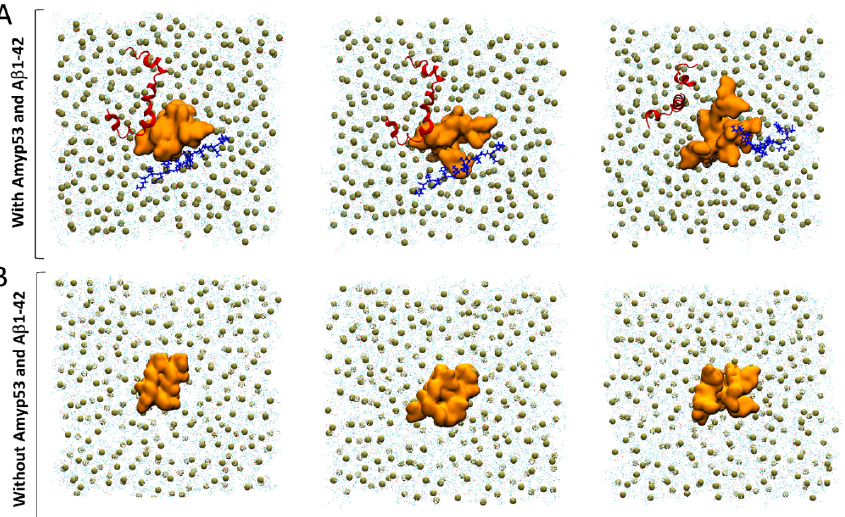
Figure 11. ( A ) Competition between AmyP53 and A β 1–42 for interacting with GM1 molecules in top view. ( B ) Conformational landscape of GM1 molecules without AmyP53 and A β 1–42 . AmyP53 is depicted as blue cartoon while A β 1–42 is depicted as red cartoon.